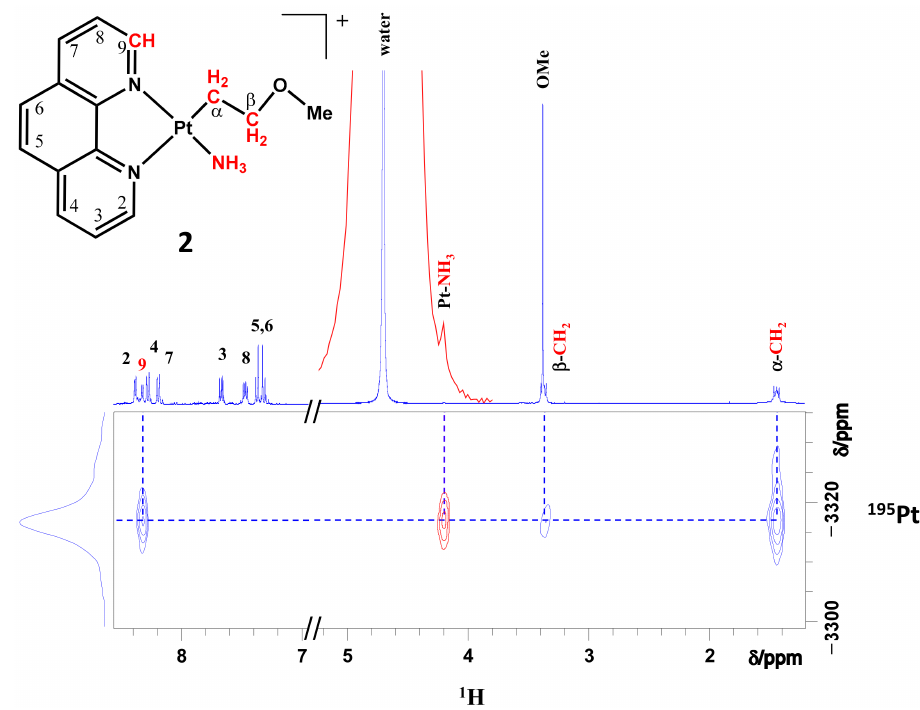
Figure 1. [ 1 H, 195 Pt]-HETCOR NMR spectrum of the [Pt( η 1 -C 2 H 4 OMe)(NH 3 )(phen)]Cl ( 2 ) complex dissolved in D 2 O. In the above-reported schematic molecular structure, the groups whose H atoms 1 H NMR signals are coupled with the 195 Pt are evidenced in red. When a H 2 O/D 2 O = 90:10 solvent mixture was used, a new cross peak, corresponding to the 1 H NMR signal of the Pt-bonded NH 3 group (indicated in red together with the corresponding 1 H NMR signal produced in the 1D 1 H NMR spectrum)